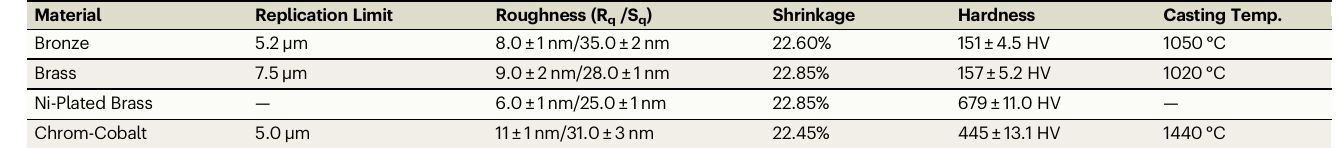
Table 1 | Characterization of the metal replication process Material Replication